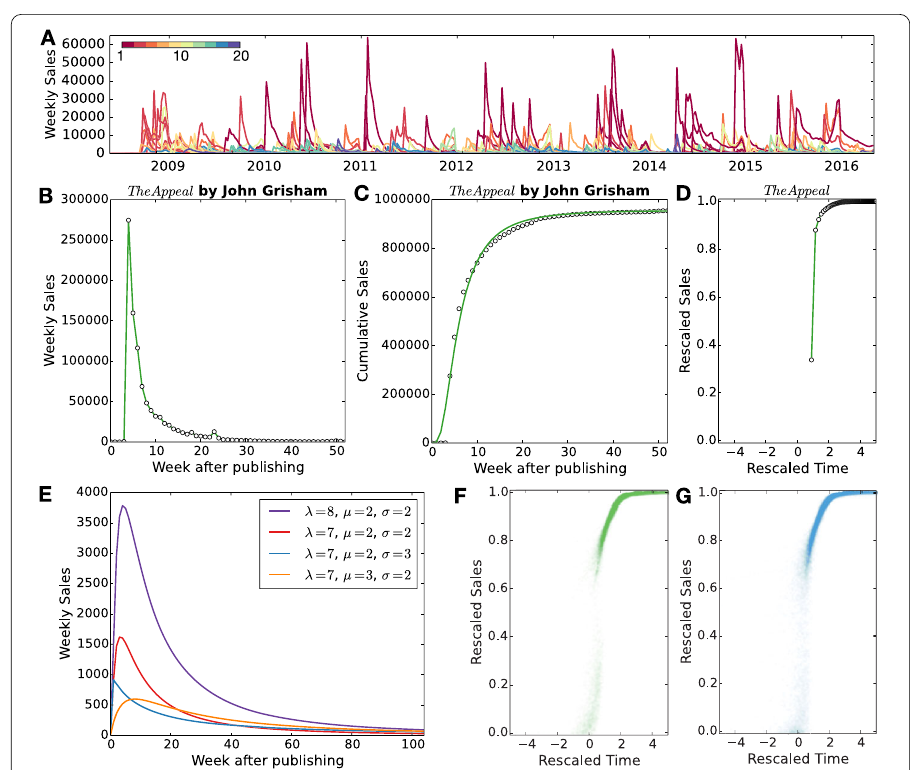
Figure 10 Modelingsalespatterns . ( A ) Weekly sales of 200 randomly selected bestsellers, with colors indicating best rank on the NYTBL. ( B ) The weekly sale numbers of the bestselling hardcover TheAppeal by John Grisham as reported by NPD Bookscan. ( C ) The fit on the cumulative sales of ( B ), empty circles showing the measured sales curve and the green line the model with parameters λ = 10.37, μ = 2.03 and σ = 1.12. The fit accurately reflects the data, as evidenced by the high R 2 = 0.99 value. The only exception are the very first weeks where data is often unreliable due to discrepancies between the reported publication date and the book’s physical availability in bookstores. ( D ) Rescaled sales curve for TheAppeal . ( E ) How weekly sale curves change for different λ , σ and μ values. By tuning these, the many different types of sales histories shown in ( A ) can be accounted for. Rescaled sales curves of all hardcover bestsellers, ( F ) fiction and ( G ) nonfiction. Most book sales curves closely follow a single formula, indicating that the model captures the patterns correctly as given in Eq.